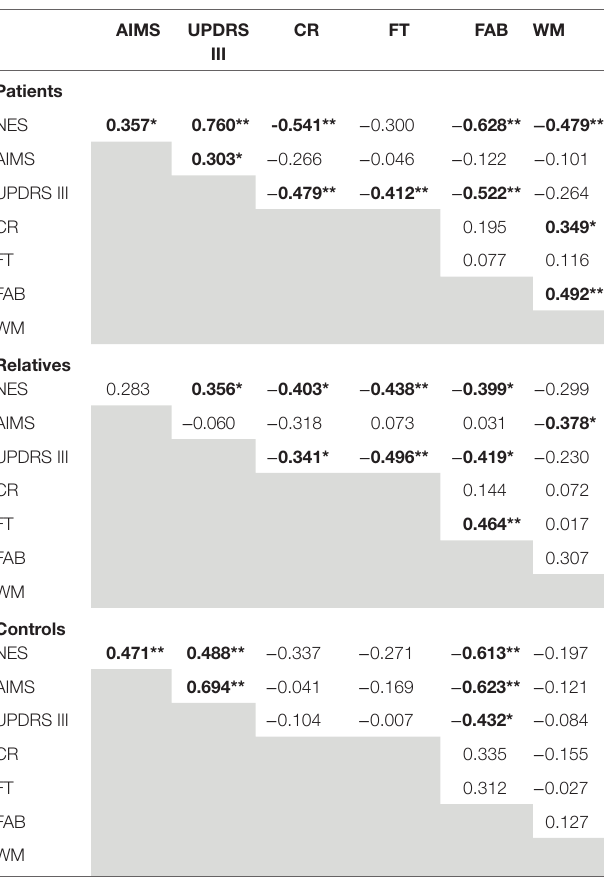
CR, coin rotation; FT, finger tapping. Table 5 | Association of motor function with frontal lobe function and working memory function in patients, relatives and